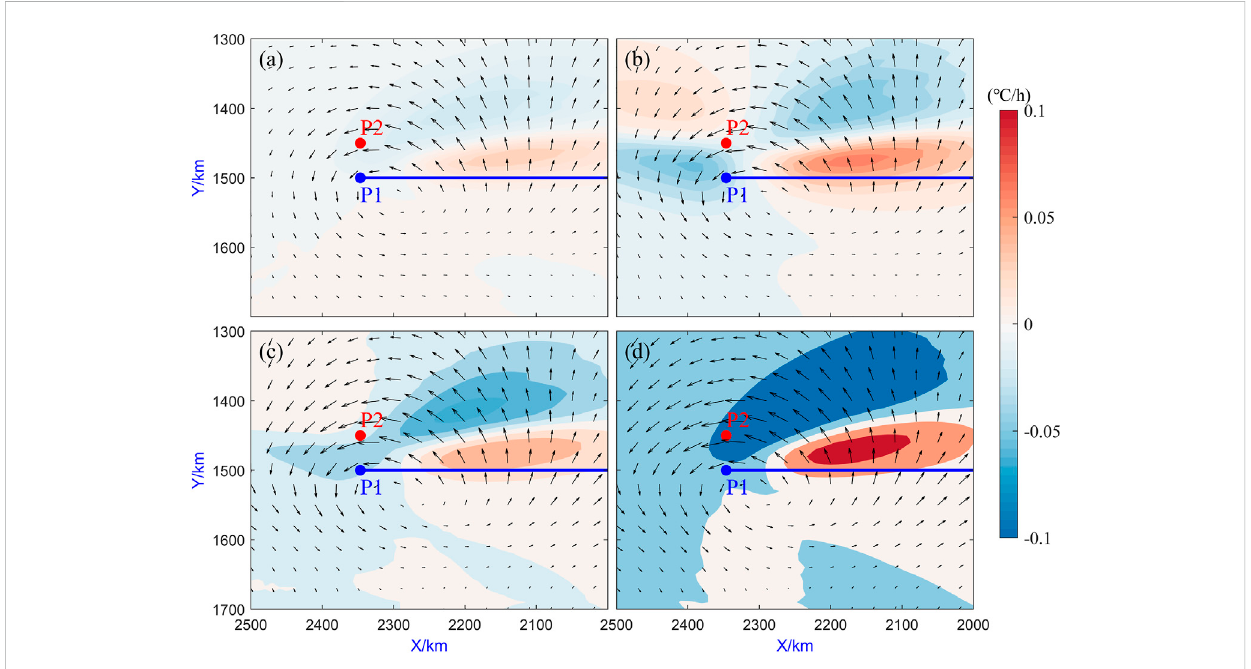
FIGURE 10 The change rate of the SST due to the horizontal advection ( ° C/h, shaded)at 0 days relativeto the LTC passage in the (A) CTRL, (B) EXP-30, (C) EXP- 45, and (D) EXP-60 experiment. The black vectors are the currents (m/s, vectors). The blue and red points label points P1 and